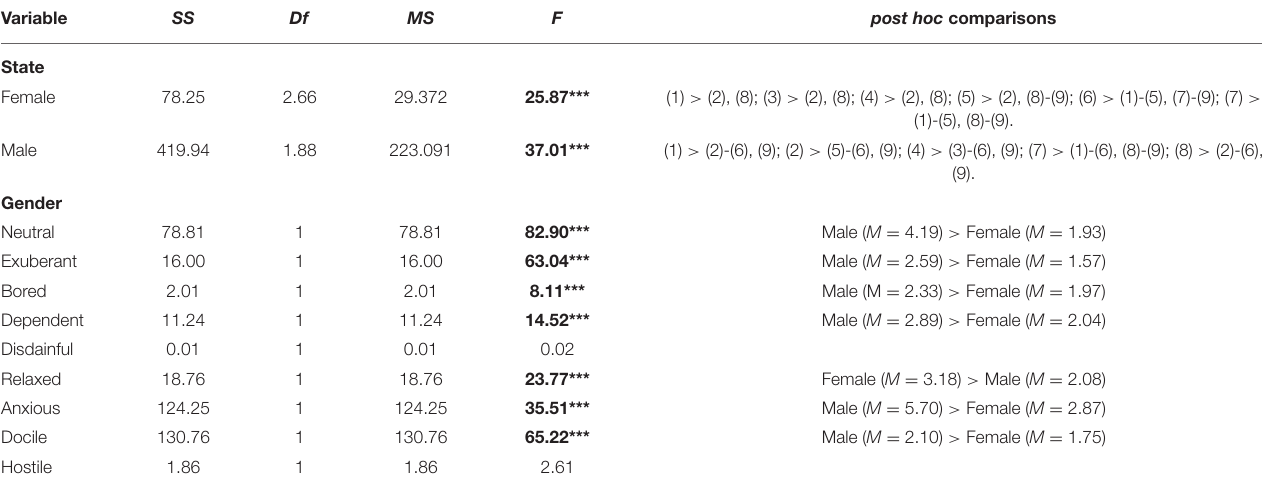
TABLE 8 | Simple main effect test of mixed design of gender and emotional states in Jitter%.